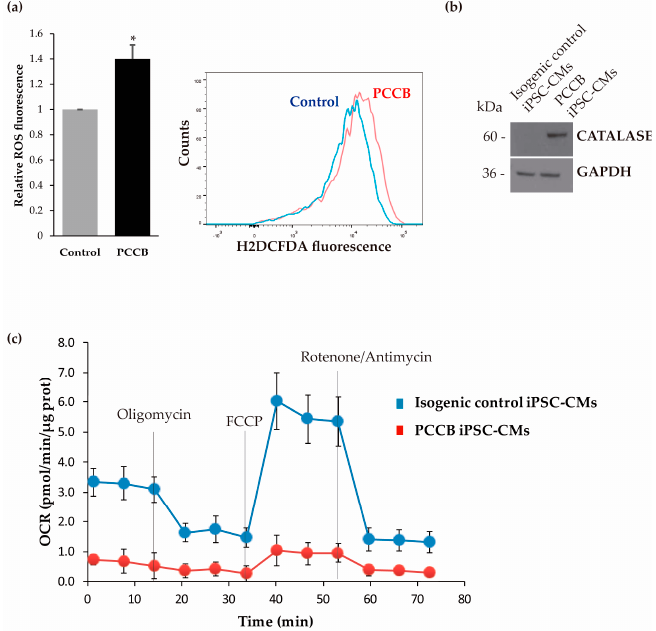
Figure 3. Analysis of oxidative stress and mitochondrial respiration in isogenic control and PCCB iPSC-CMs. ( a ) Detection of intracellular ROS level by flow cytometry using H 2 DCFDA as a fluorescence probe under basal conditions. Data represent mean values ± SD from at least three independent experiments. Statistical significance was determined by Student’s t -test. * p < 0.05. A representative experiment of ROS level in isogenic control iPSC-CMs (control in blue) and PCCB iPSC-CMs (PCCB in red) is shown. ( b ) Expression analysis of catalase protein by Western Blot. A representative blot is shown, and GADPH was used as a loading control. At least three experiments were performed. The corresponding quantification of proteins by laser densitometry is not shown because of the total absence of catalase enzyme in isogenic control iPSC-CMs. ( c ) Bioenergetic profile of WT and PCCB iPSC-CMs. Representative profile of basal OCR in isogenic control and PCCB iPSC-CMs after the addition of oligomycin, FCCP, rotenone, and antimycin A. The results shown are mean ± standard deviation of 3 to 5 experiments.